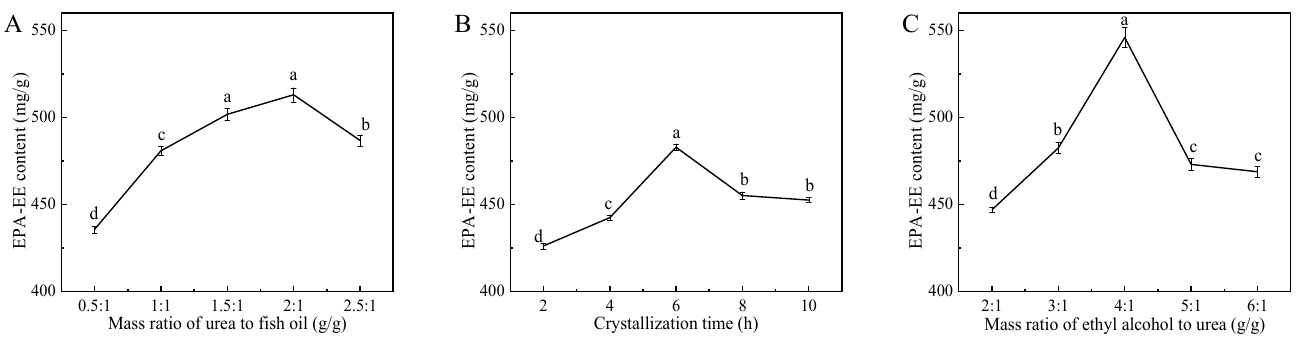
Figure 3. Effect of mass ratio of urea to fish oil ( A ), crystallization time ( B ) and mass ratio of ethyl alcohol to urea ( C ) on EPA-EE content of fish oils in the process of urea complexation. Values with different lowercase letters (a–d) in each panel are significantly different at p < 0.05.